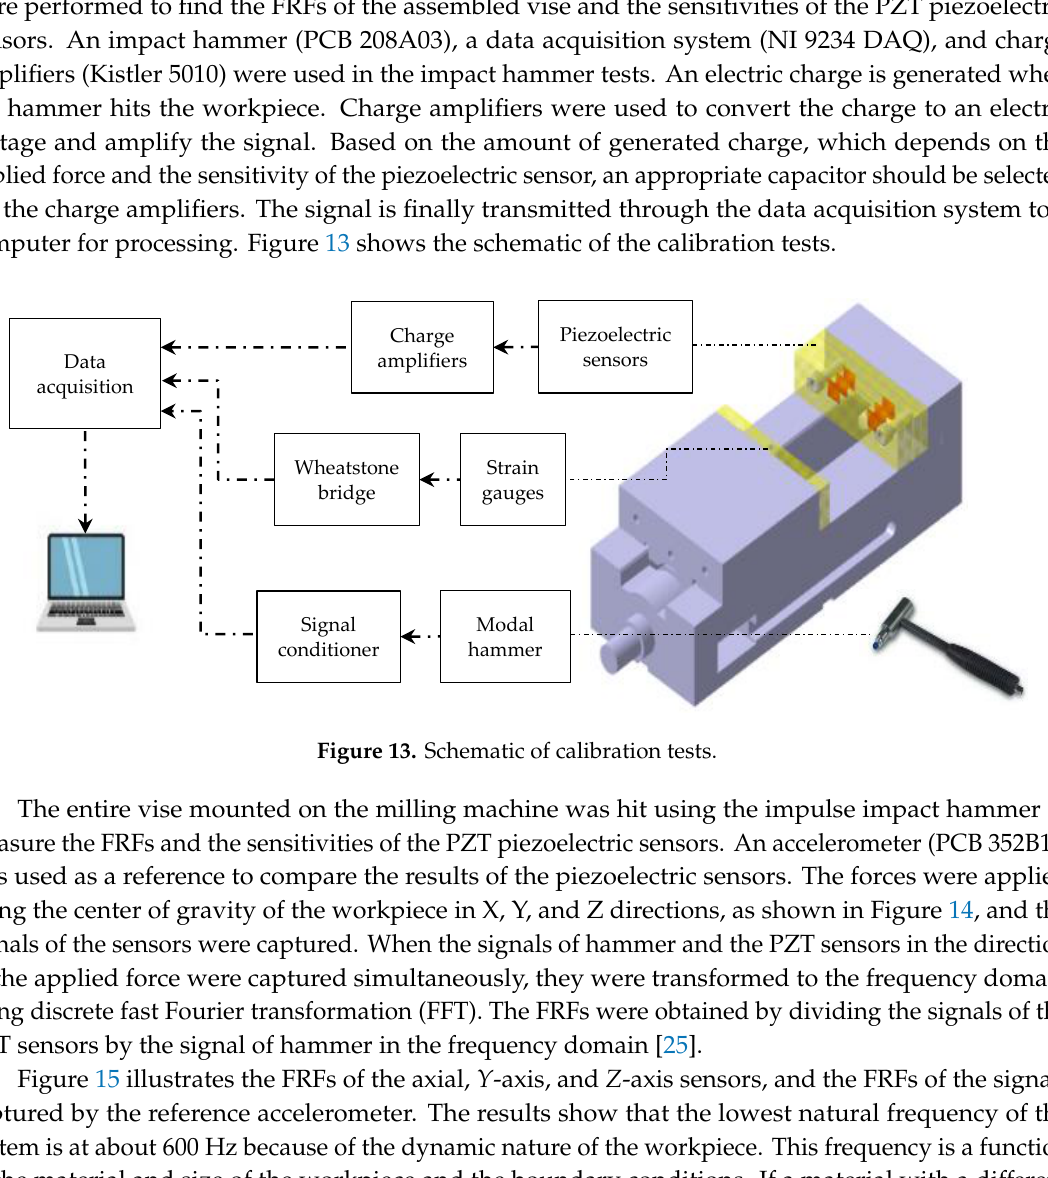
Figure 12. Simulation to investigate the stress field of the piezoelectric sensors and the setup by applying equivalent bolt loads to each screw: ( a ) the boundary conditions and the loads applied on the screws; the stress distribution (Pa) on ( b ) the first layer, ( c ) the second layer and Z -axis sensors, ( d ) the third layer and Y -axis sensors, ( e ) the fourth layer and X -axis sensors, and ( f ) one of the X -axis sensors.